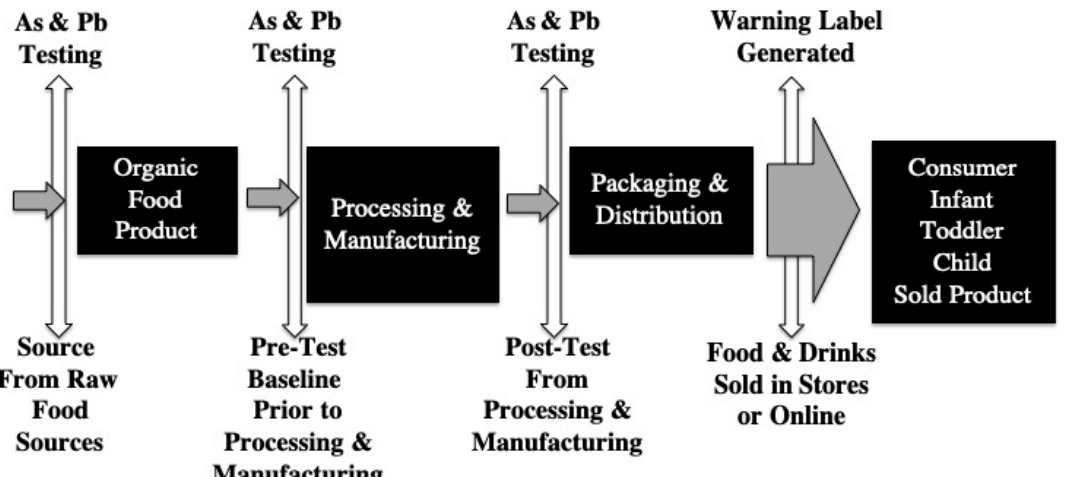
Figure 1. A schematic suggesting how to achieve As- and Pb-free food by sequential testing through- out the manufacturing process. This process aims to limit human As- and Pb-exposures, especially for infants, toddlers, and children. The grey directional arrows indicate the source-to-consumer process; the white double arrows indicate the testing phase for assuring As- and Pb-free foods; and the black boxes indicate the steps in the manufacturing process for achieving the production of As- and Pb-free foods from farm-to-table. The end goal is to establish clear limits for As and Pb in foods and drinks, and to inform the consumer through warning labels for all consumable goods sold in stores or online.